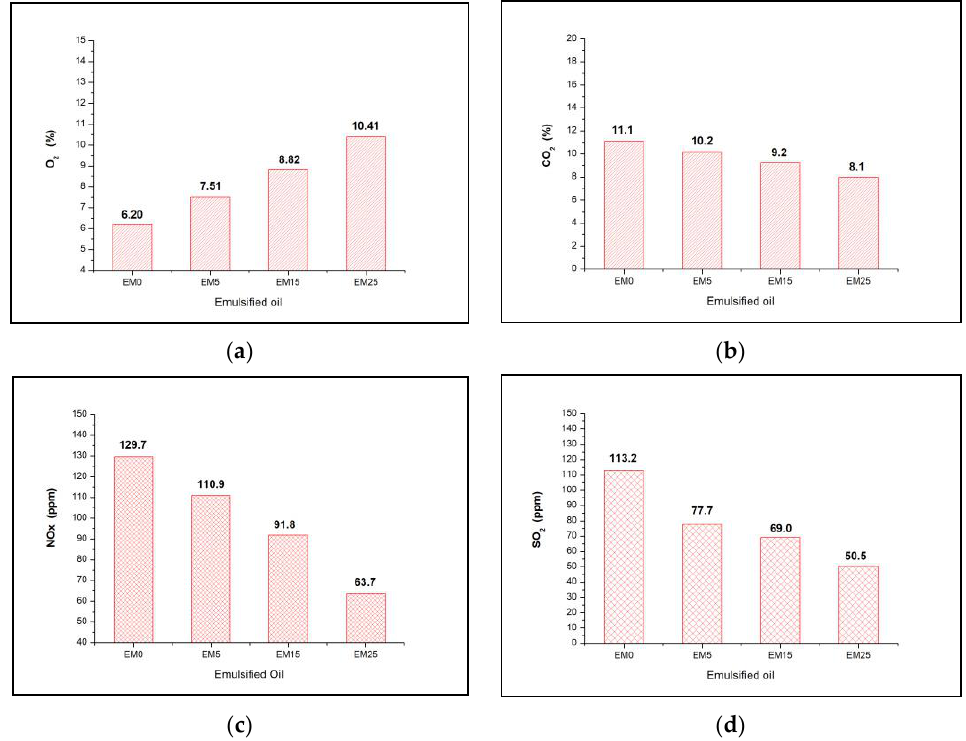
Figure 8. Exhaust gas emissions comparison of emulsified oil: ( a ) O 2 , ( b ) CO 2 , ( c ) NO x , and ( d ) SO 2 . The SO x concentration significantly decreased by approximately 62.7% from 113.2